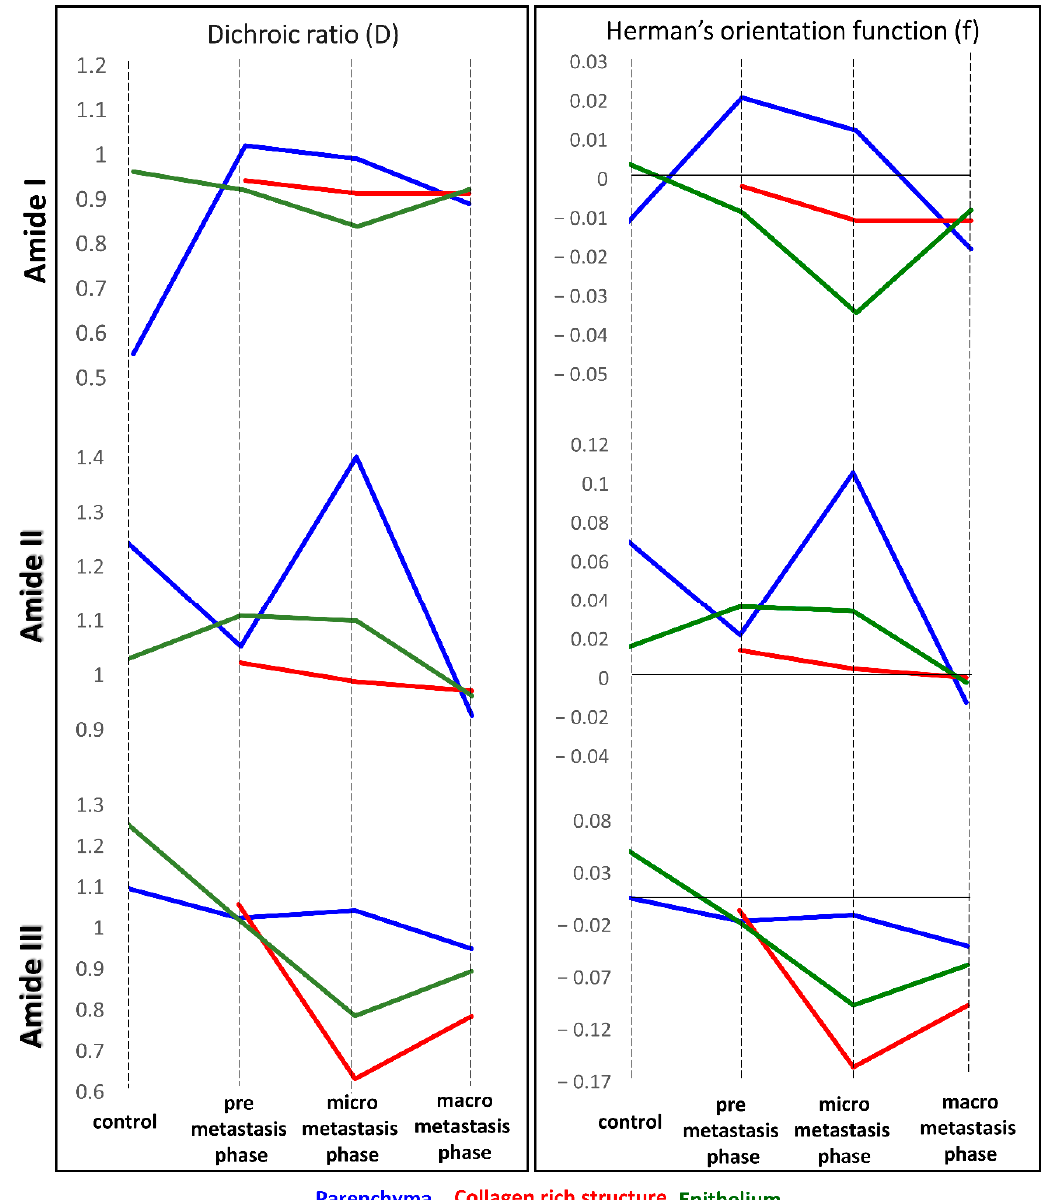
Figure 5. The graph shows the values of D and f and their changes depending on the phase of metastasis from the Table